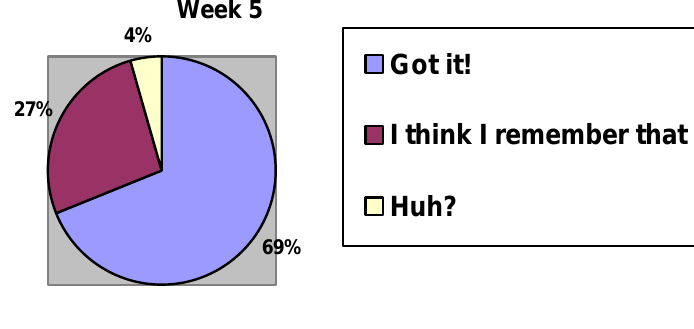
Figure 11. Student Comprehension Checklist compiled during the fifth week of the implementation of posting and communicating daily learning objectives